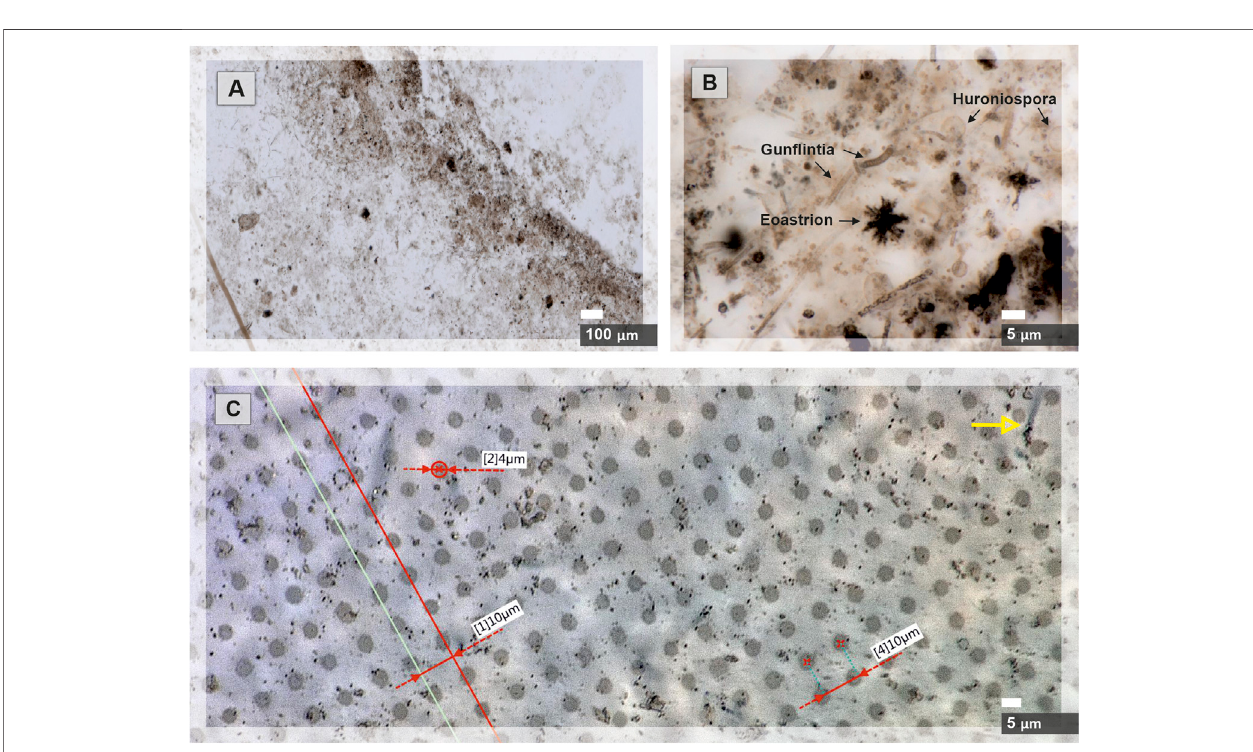
FIGURE 2 | Microscope images of the Gun fl int chert before and after the fs-LIMS imaging campaign are shown. (A) Microscope image of the area (0.9*2 mm 2 ) chosenforthechemicalimagingwithourfs-LIMSsystem.Thedarkbrownpatchesdistributedthroughthesampleandformingadiffuselayerinthemiddleofthepicture represent a bio-lamination surface. (B) Close-up microscope picture of individual microfossils from the bio-lamination surface. Filamentous (Gun fl intia), star-shaped (Eoastrion), and spherular microfossils (Huroniospora) can be seen. (C) Microscope picture of laser ablation craters (0.9*2 mm 2 area covered with 90*200 pixels – 18,000 ablation positions) formed after the fs-LIMS imaging campaign. Red lines denote the accuracy of sample positioning (the gap between ablation craters is consistently 10 µm) and identify the ablation crater diameters. Individualcraters range indiameter from 4to 5 µm.Note, on the upper part of theimage, the yellow arrow indicates an individual microfossil body. The size of the microfossil can be compared with the diameter of the analytical spot.